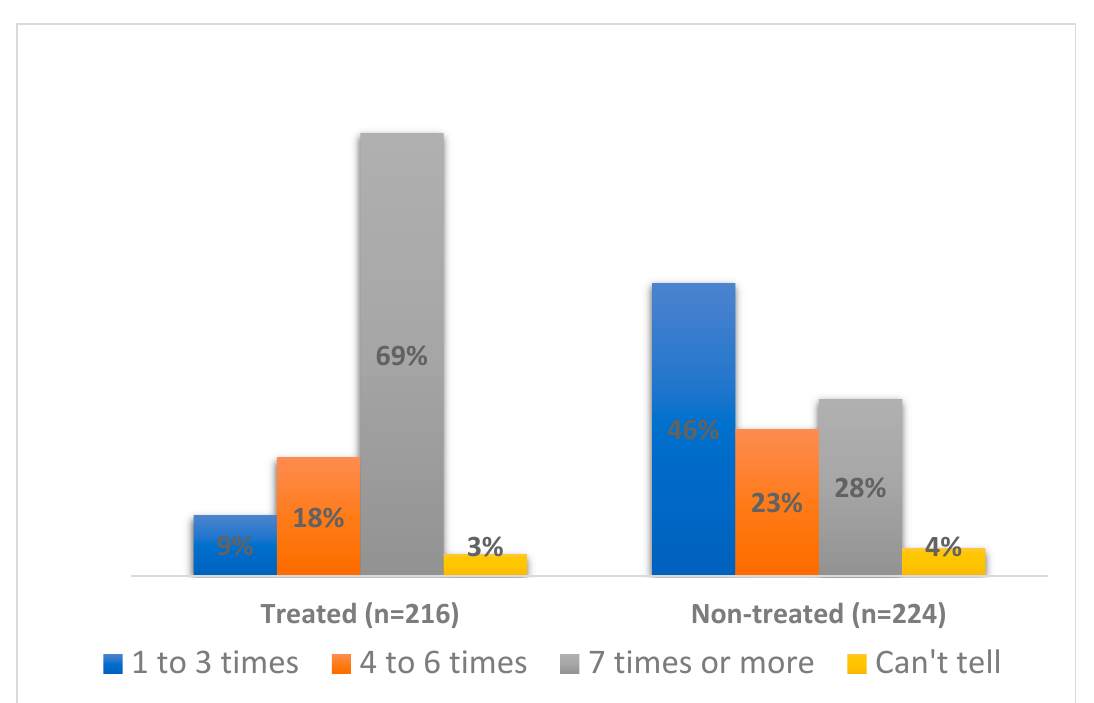
Figure 1. Percentage distribution of times respondents reported taking the MDA drugs.